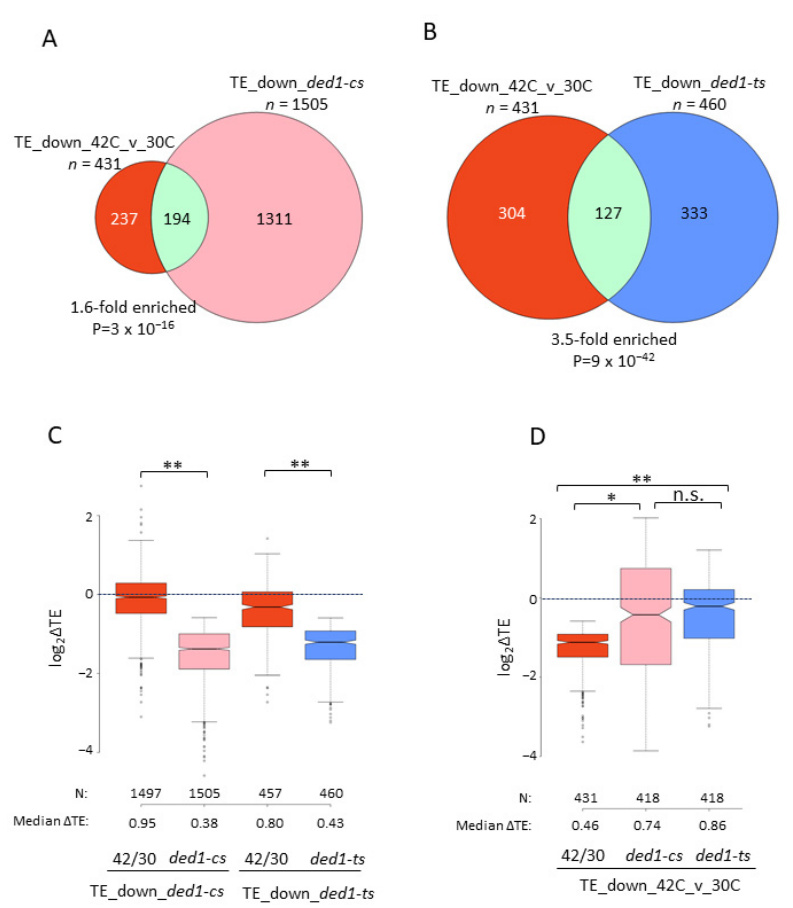
Figure 3. A significant fraction of Ded1-hyperdependent mRNAs translationally down-regulated by the ded1-ts or ded1-cs mutations is translationally down-regulated by the heat-shock of WT cells at 42 ◦ C versus 30 ◦ C. ( A , B ) Overlap between the 431 TE_down_42C_v_30C mRNAs and either the TE_down_ ded-cs ( A ) or TE_down_ ded-ts ( B ) mRNAs described in Figure 1. ( C ) Log 2 fold changes in TE in response to the heat-shock of WT cells at 42 ◦ C versus 30 ◦ C (42C/30C), ded1-cs, or ded1-ts for the 1505 TE_down_ ded1-cs mRNAs (cols. 1–2) or 460 TE_down_ ded1-ts mRNAs (cols. 3–4). ( D ) Log 2 fold-changes in TE in response to heat-shock at 42 ◦ C vs. 30 ◦ C, ded1-cs, or ded1-ts for the 431 TE_down_42C_v_30C mRNAs. One outlier mRNA was omitted from the box plots in C and D to expand the y -axis scale. p -values computed from Mann–Whitney U -test are given (* p < 10 − 13 ; ** p < 10 − 15 ; n.s., not significant).